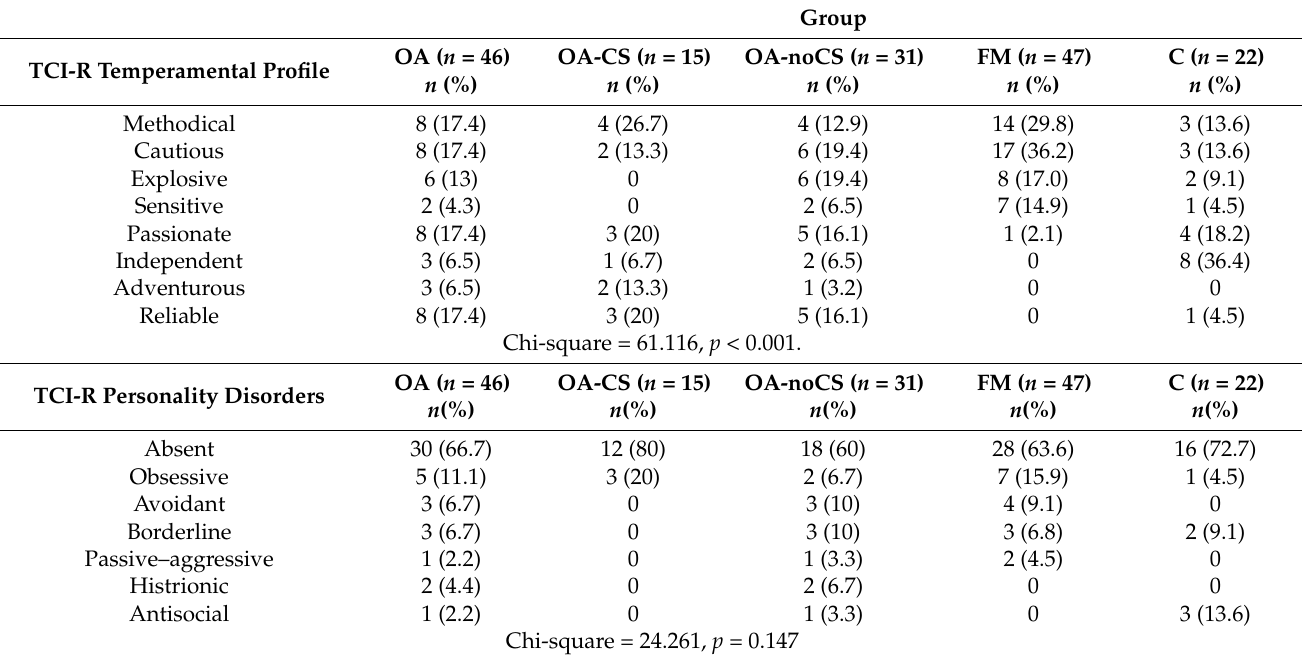
Table 3. Distribution of TCI-R temperamental profiles and TCI-R personality disorders by group. Group